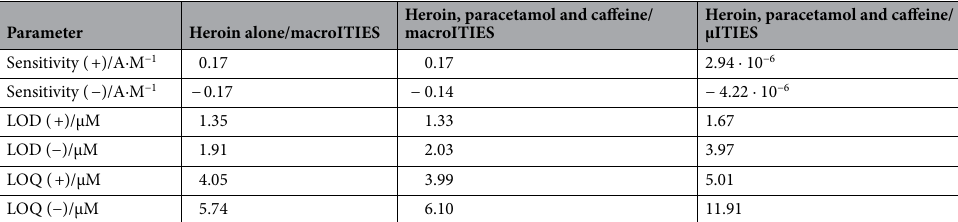
Table 2. The summary of the electroanalytical parameters obtained for heroine alone and in the presence of caffeine and paracetamol for macroscopic and microscopic eLLI.